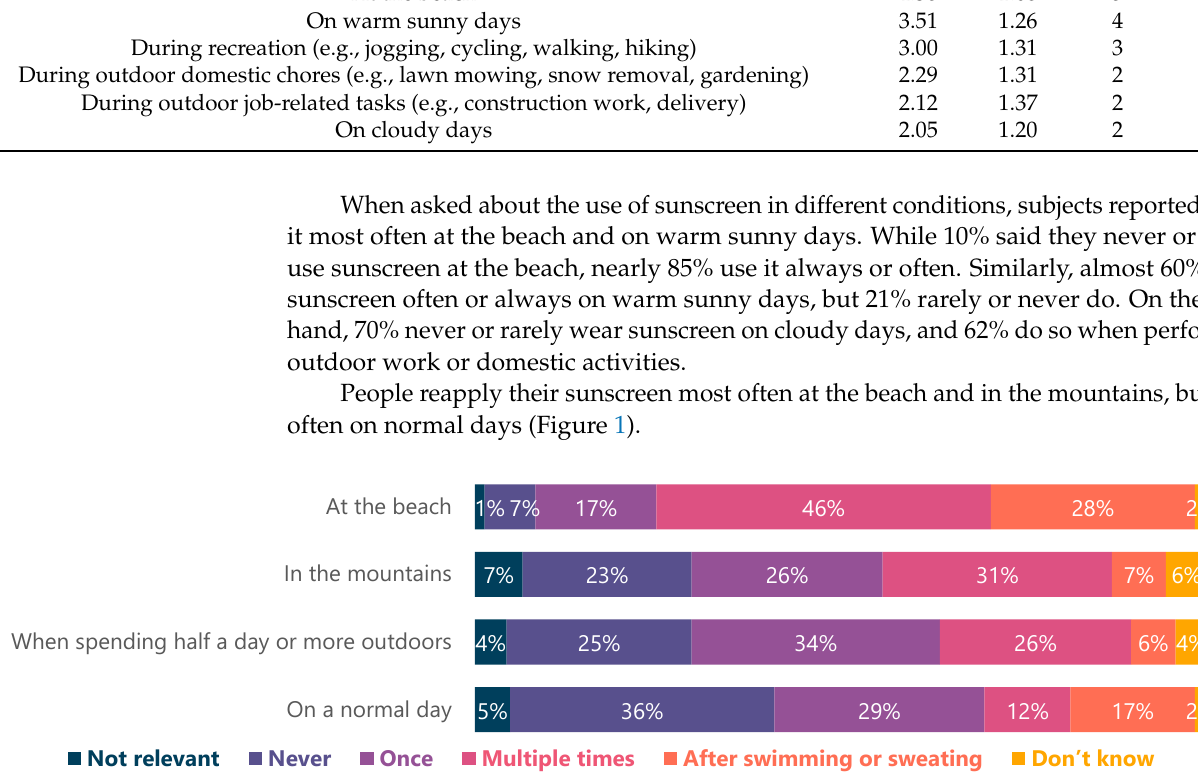
Figure 1. Frequency of sunscreen reapplication in various circumstances.